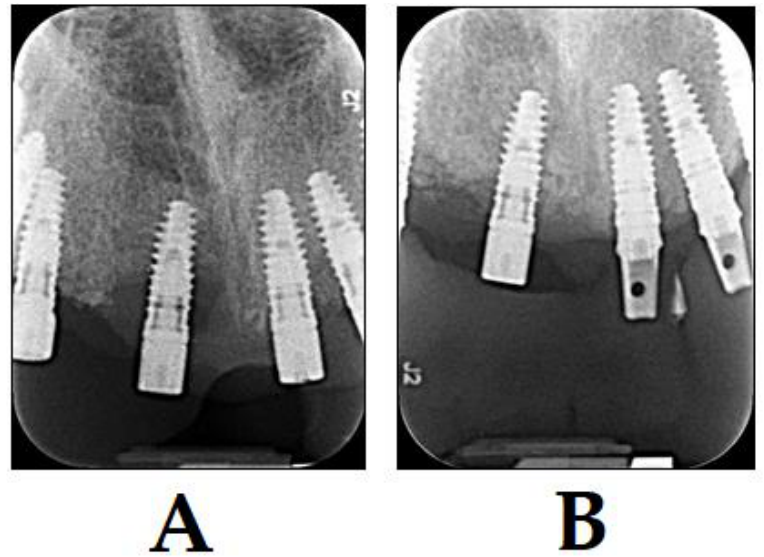
Figure 7. Treatment of patients with peri-implantitis with PDT and BIOOSS bone graft material (photo courtesy of R. Szab ó DMD, J. Arentz DMD and T. Nave DMD). ( A ) X-ray of diagnosis of peri-implantitis before treatment; and ( B ) X-ray 3 months after treatment with PDT and BIOOSS bone graft material. Bone regeneration is visible showing a clear sign of healing.